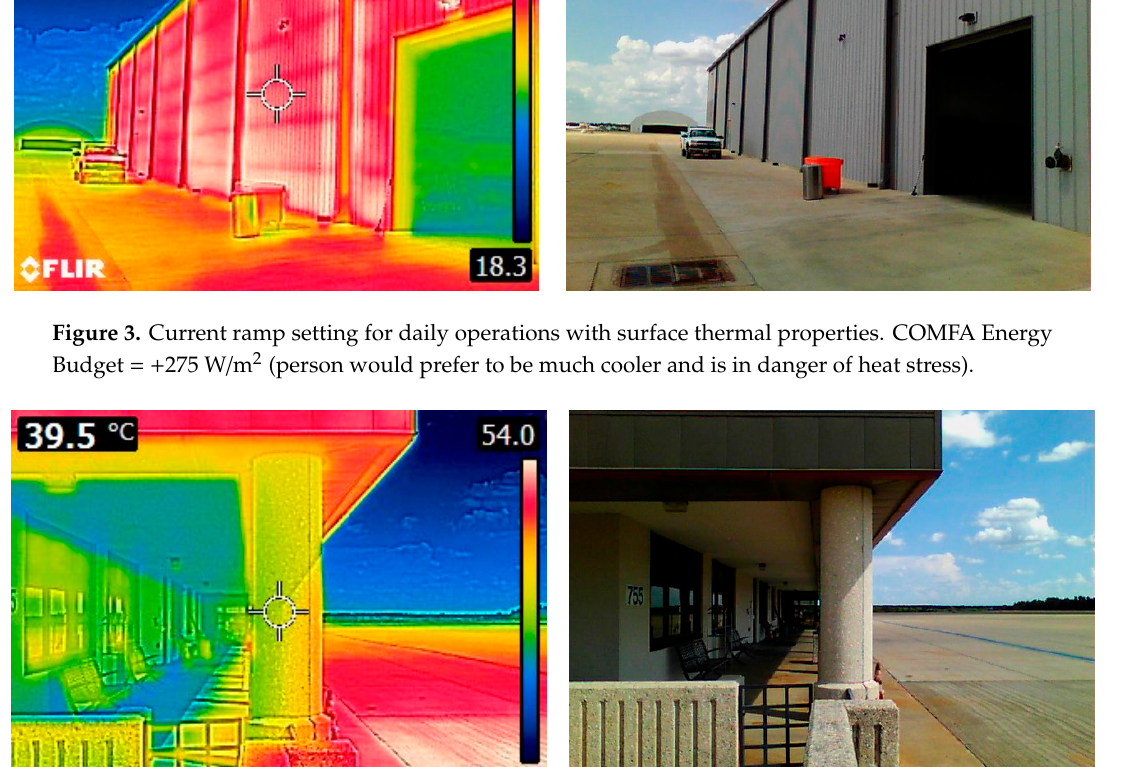
Figure 4. Airport building with shaded verandah and surface thermal properties. COMFA Energy Budget = +133 W/m 2 (thermally comfortable and safe).